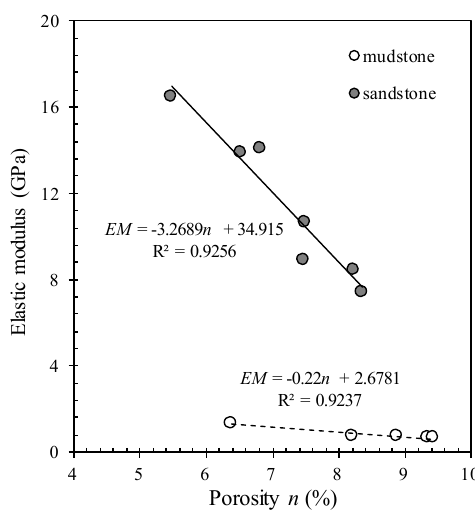
Figure 17. Relationship between the EM and the porosity.